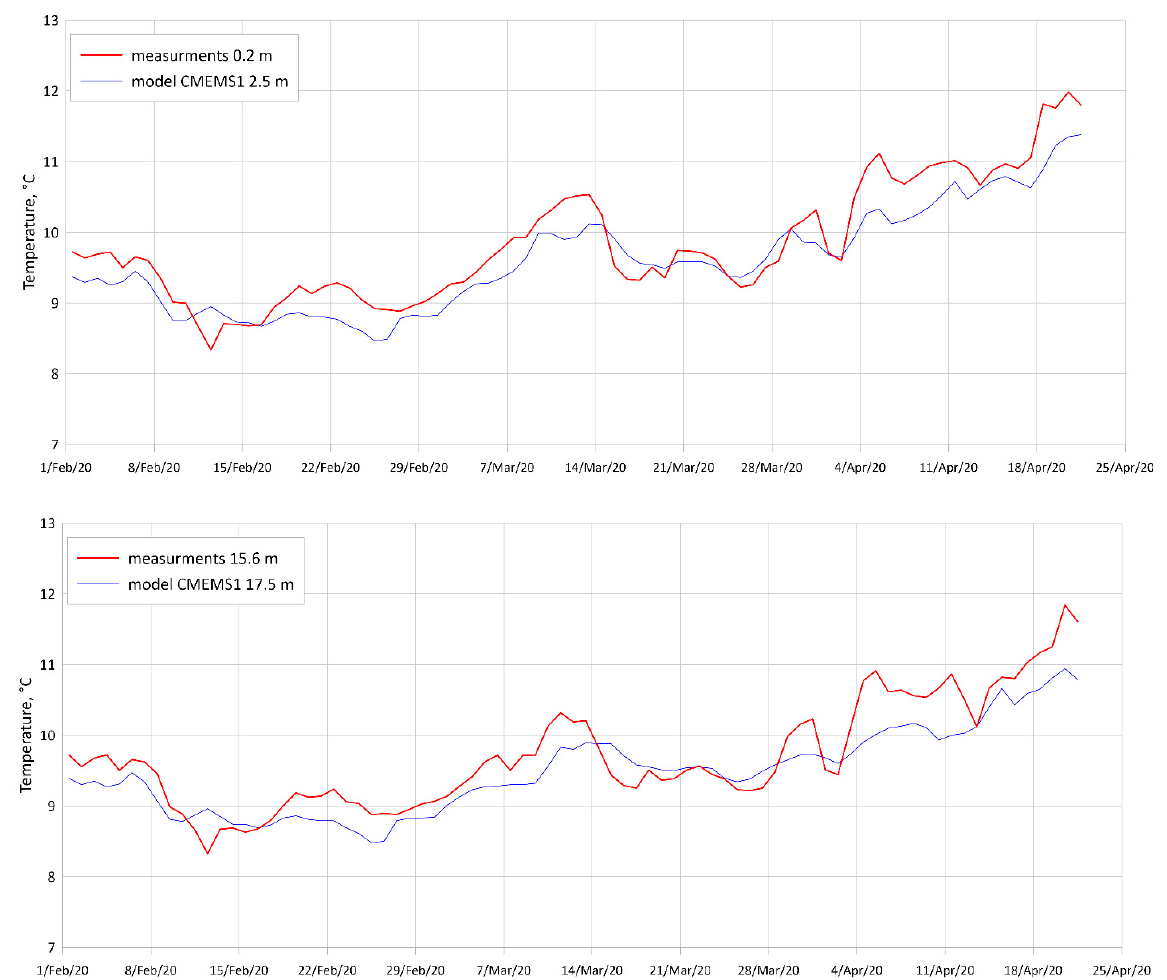
Figure 17. Water temperature at the surface and the 15 m layer according to the measurements (red line) and CMEMS1 model data (blue line) from 1 February to 25 April 2020.